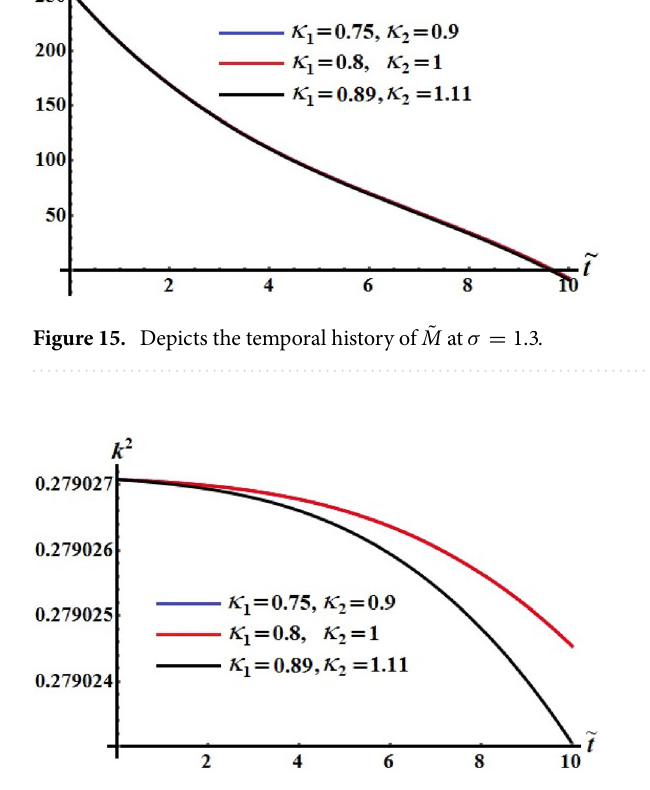
Figure 16. Portrays the temporal history of k 2 at σ = 1.3 .